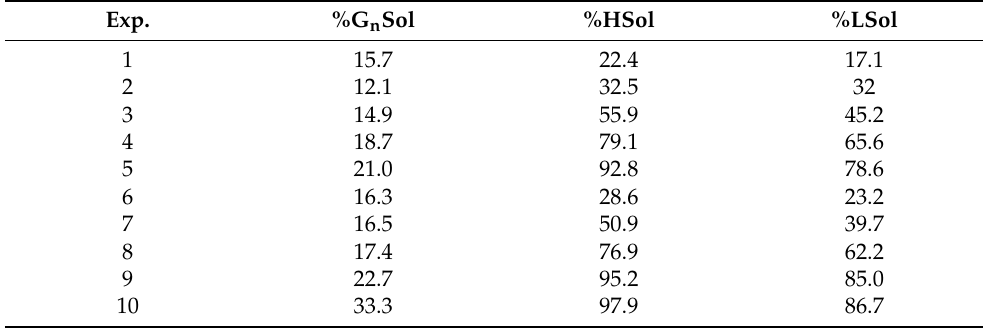
Table 2. Values of variables defined to assess the fractionation AD under the conditions listed in Table